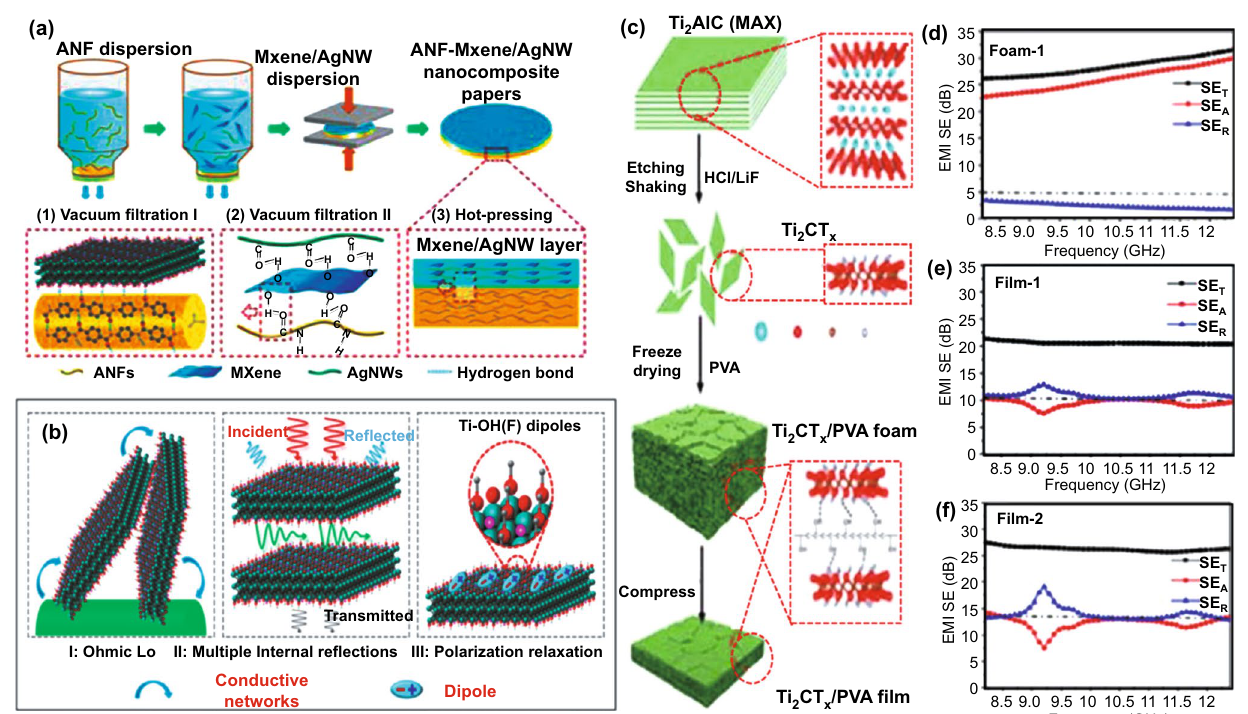
Fig. 11 a Schematic diagram for the fabrication of double-layered ANF-MXene/AgNW nanocomposite papers. b EMI shielding mechanism of the double-layered nanocomposite papers [99]. Copyright © 2020 American Chemical Society. c Illustration of the preparation process of Ti 2 CT x /PVA composite foam and film. d Proposed EMI shielding mechanism of MXene/PVA composites with a foam or film structure. e, f EMI shielding performances of